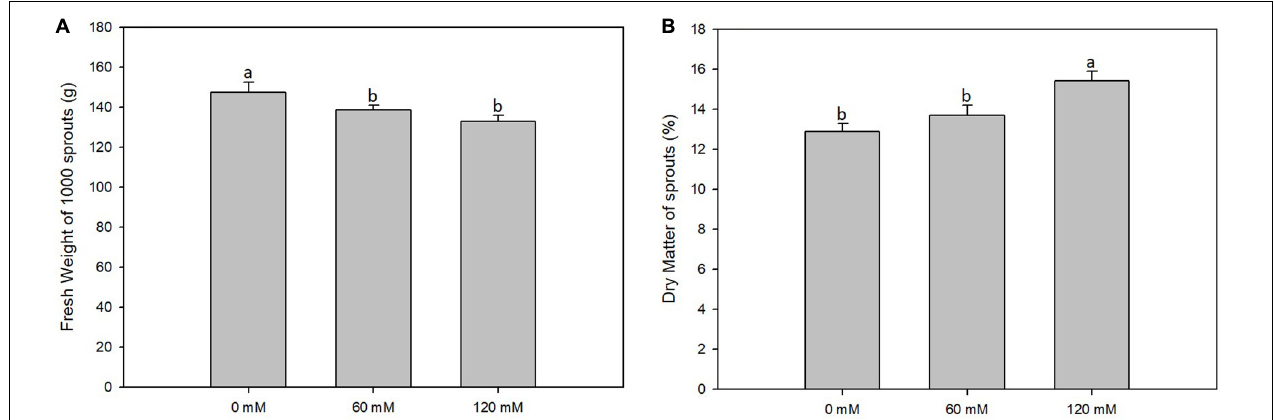
FIGURE 1 | Fresh weight (A) and dry weight (B) percentage of altilis sprouts grown at different salt concentrations (0, 60, and 120 mM). The error bars represent the error mean of three biological replicates. Different letters indicate differences at P ≤ 0.05 (ANOVA).